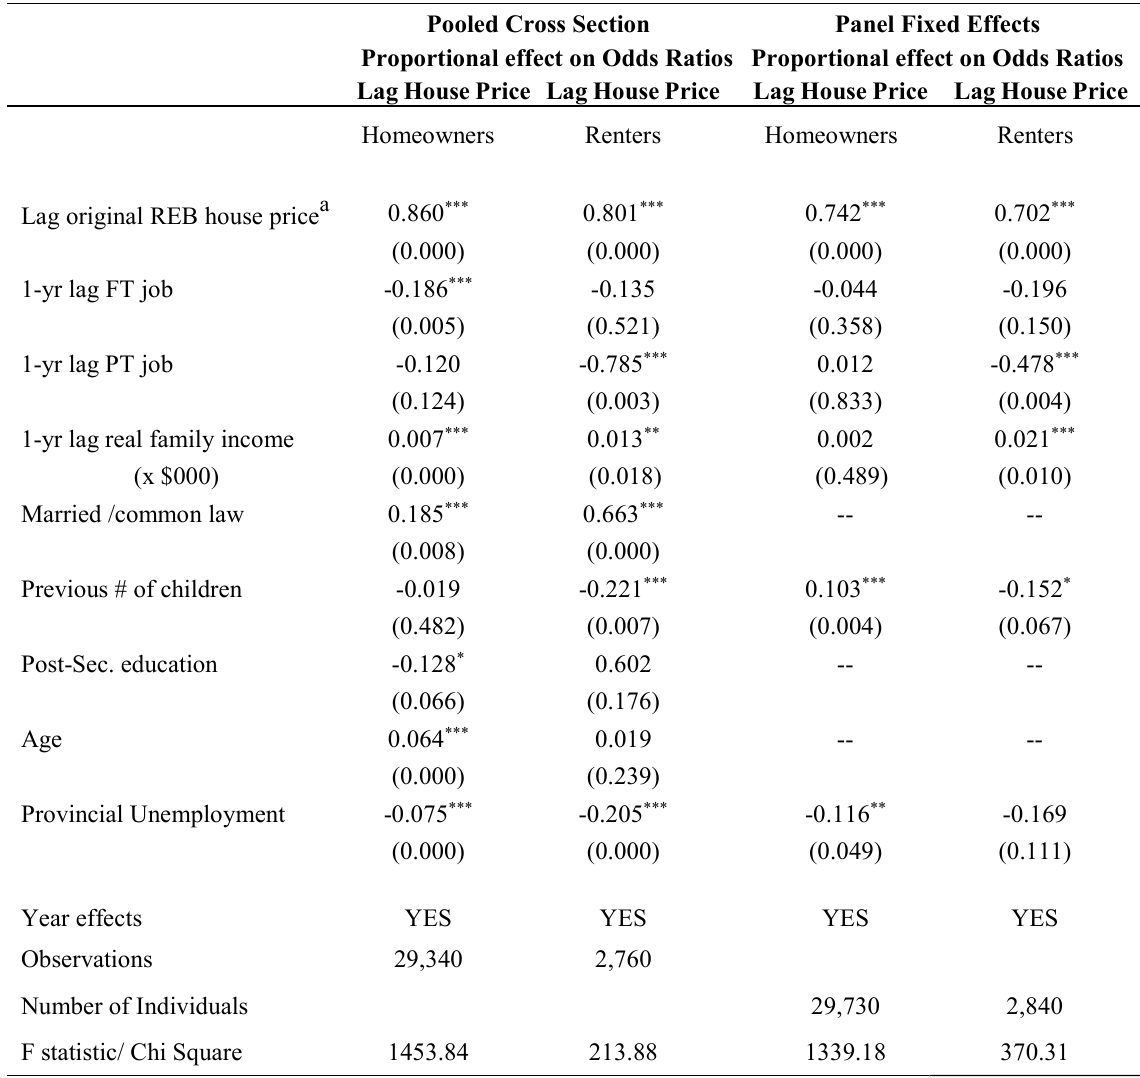
Appendix Table 4 : First stage regressions for 2SLS in Table 4 Rows (3) and (6) (includes movers